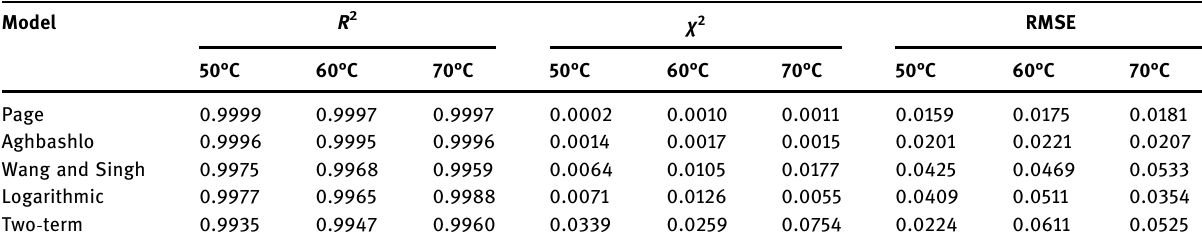
Table 2: Statistical parameters characterizing the modelling of pomegranate arils ’ drying in CV dryer